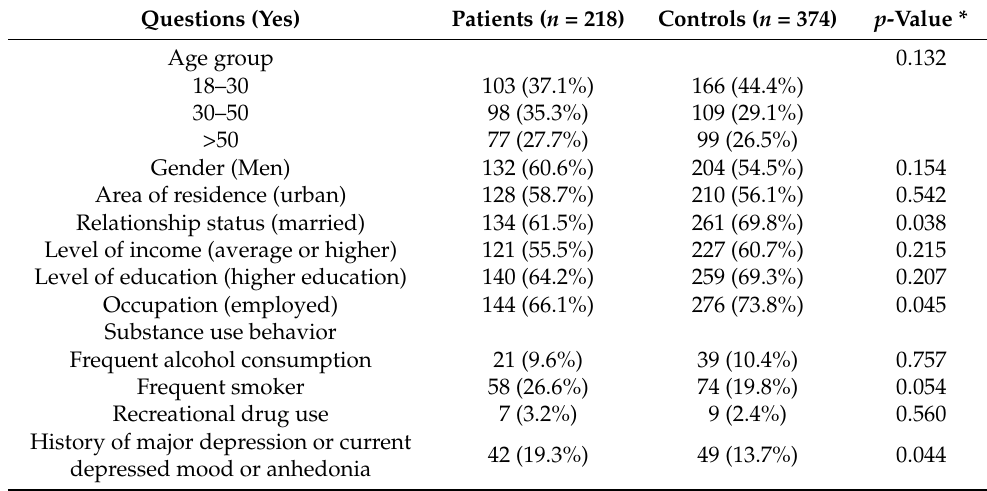
Table 1. Comparison of background data from patients and controls.